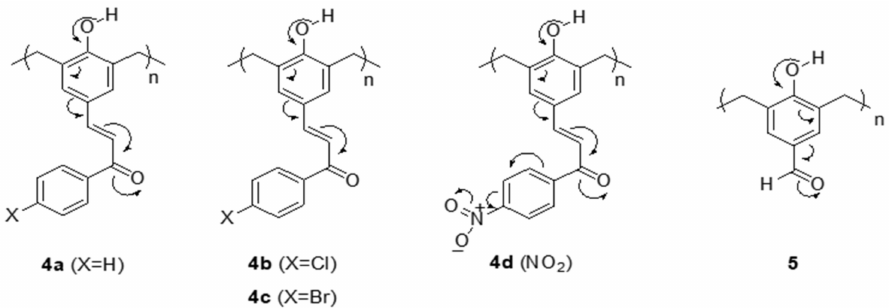
Figure 5. Possible resonating structures of 4a , 4b , 4c , 4d , and 5 phenolic polymers.